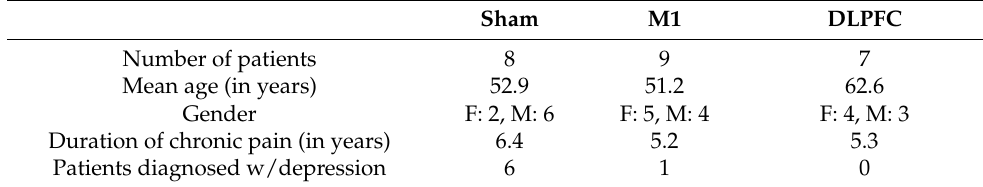
Table 1. Demographic information of patients who completed the experimental